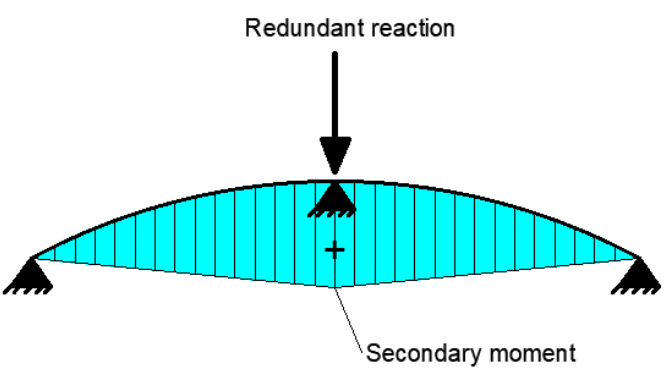
Figure 9. Effect of the secondary moment in curved